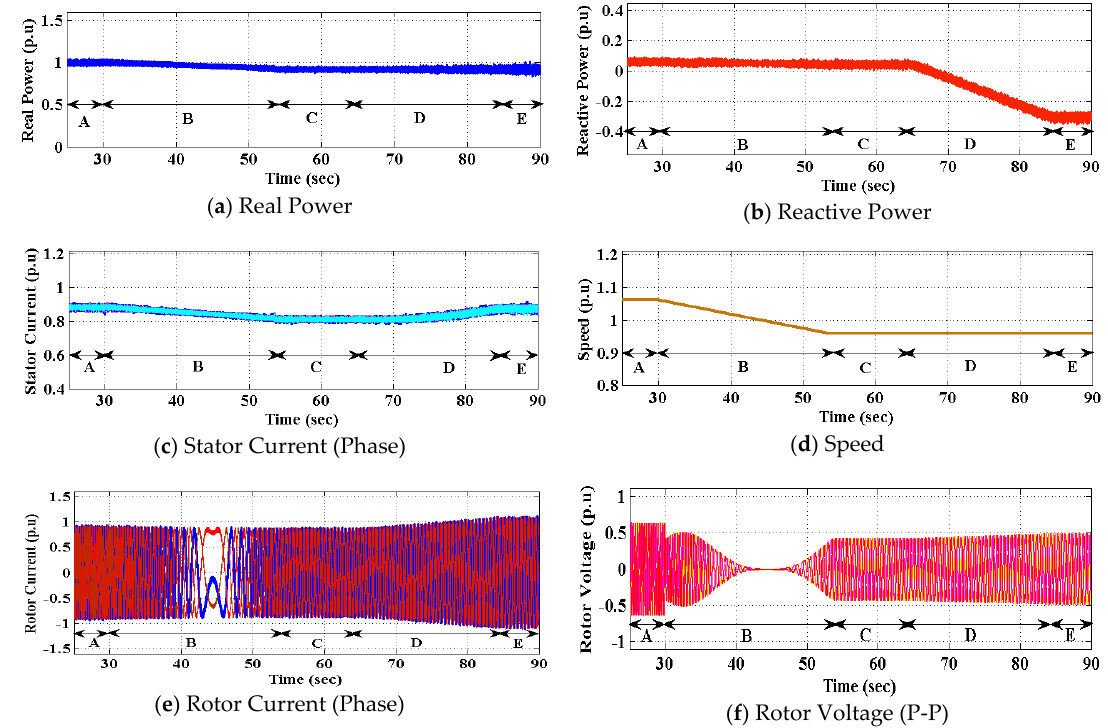
Figure 2. Active and reactive power control of 250 MW DFIM. A—260 MW, 15.3 MVAr (consumption), 245 rpm; B—Transition from 260 to 240 MW, 245 to 221.5 rpm, 15.3. MVAr (consumption); C—240 MW, 221.5 rpm, 15.3 MVAr (consumption); D—Transition from 15.3 MVAr (consumption) to 91.8 MVAr (Deliver to grid); E—240 MW, 91.8 MVAr (Deliver to grid), 221.5 rpm.